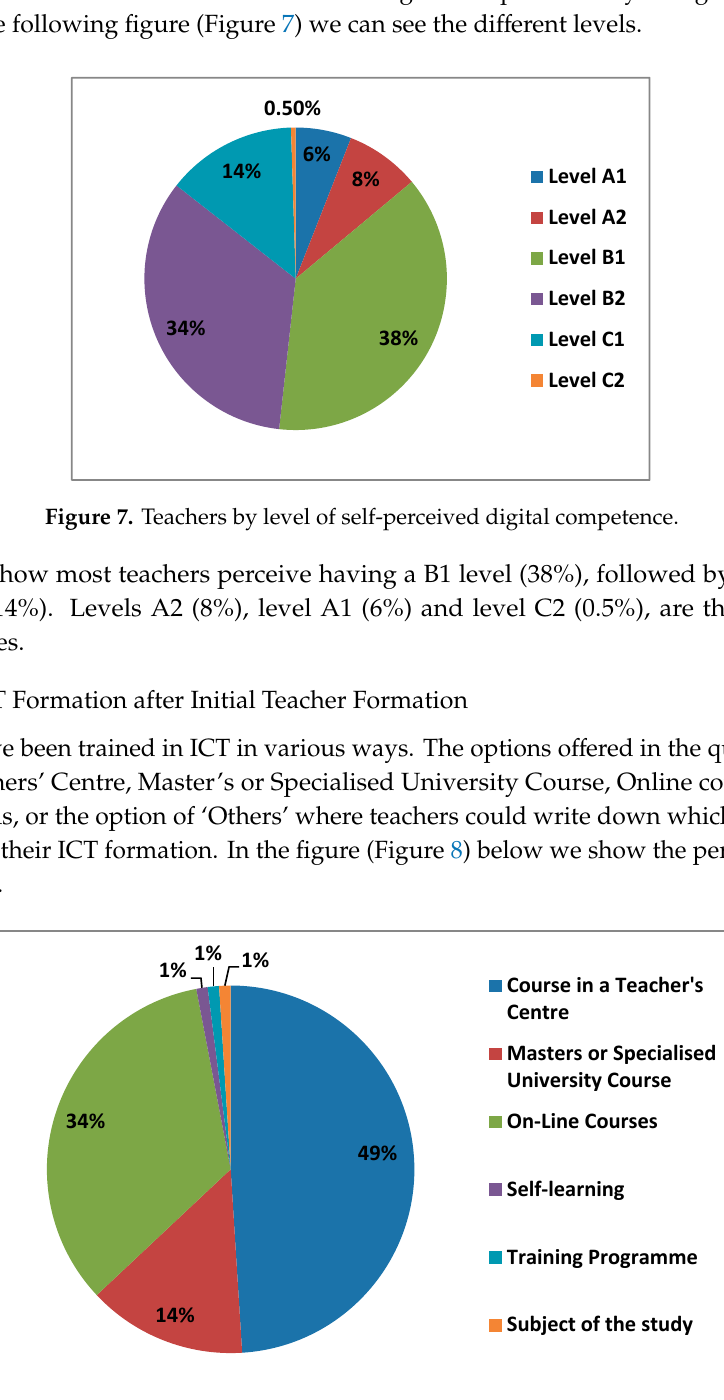
Figure 8. Post-study ICT formation for teachers.